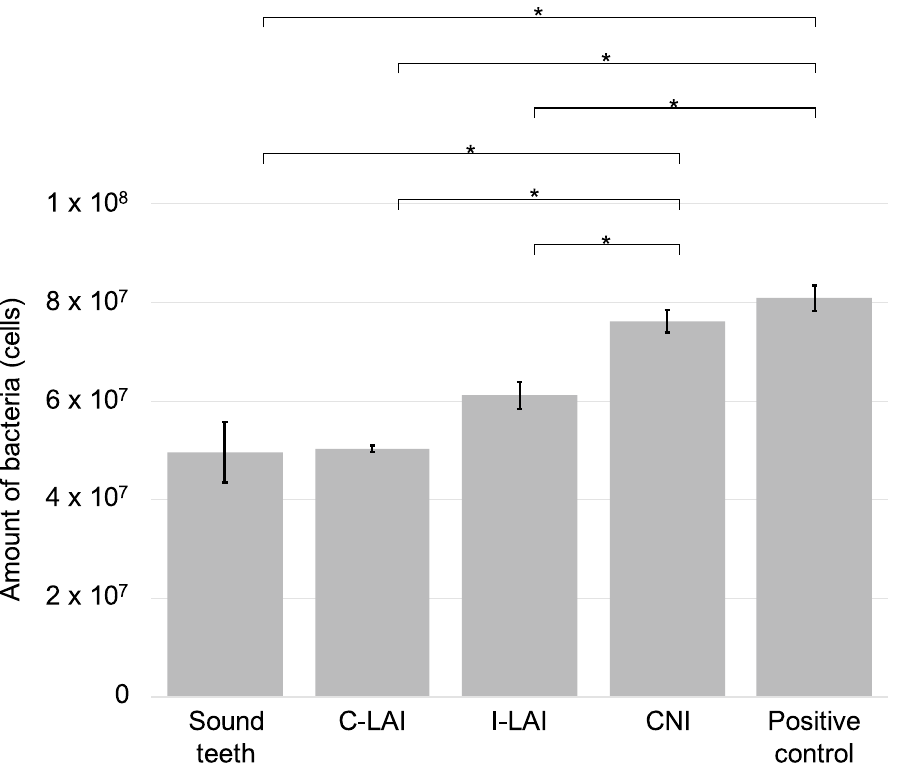
Figure 2. Quantitative evaluation of the number of bacteria in the root canal by qPCR. The I-LAI and C-LAI groups had a significantly lower bacterial concentration than either the positive control or CNI groups. There was no significant difference found between the I-LAI and C-LAI groups. The number of bacteria in the positive control and CNI groups was significantly higher than that in the sound teeth. However, the bacterial levels in both LAI groups were not significantly different from those in the sound